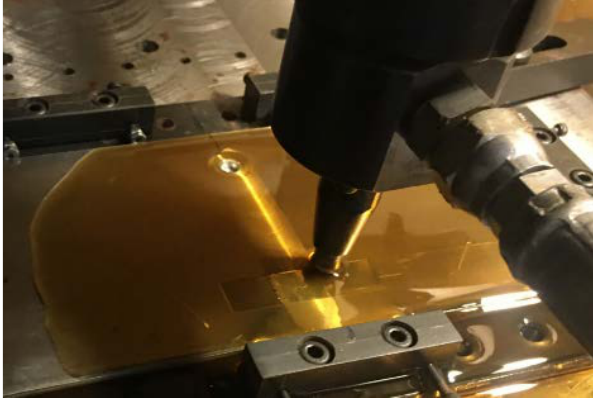
Figure 5. Deep rolling process.